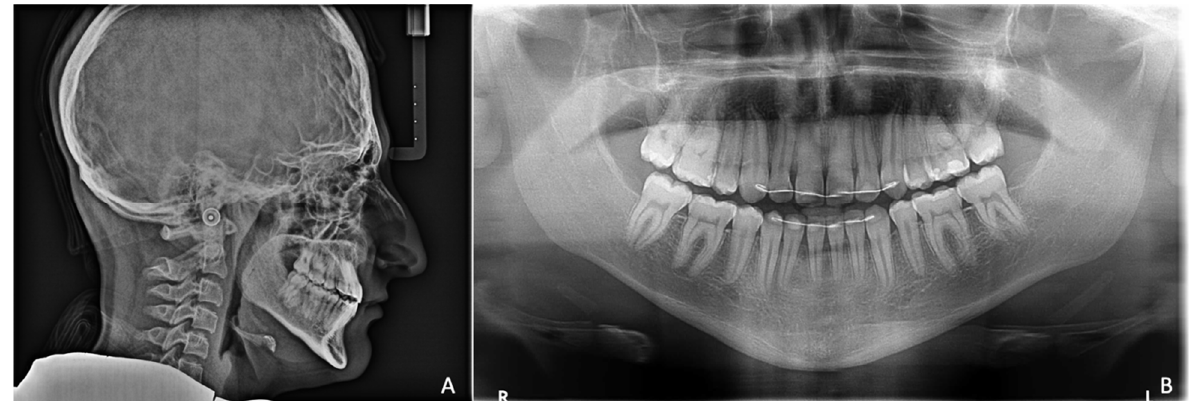
Figure 6. Posttreatment radiographs at the age of 15. ( A ). Lateral cephalogram at the end of the orthodontic retention period showing a slight relapse of the skeletal relationship. ( B ). Orthopantomogram showing the stable result with aligned canines.